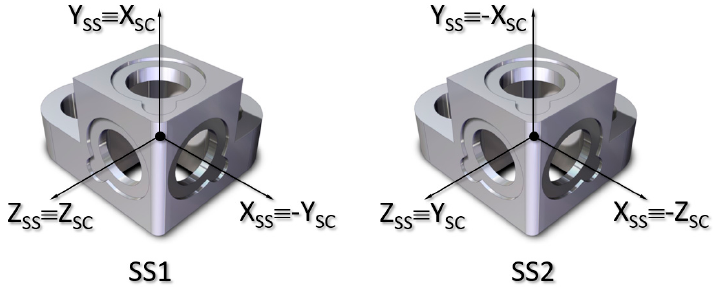
Figure 4. Solar sensor reference system (X SS , Y SS , and Z SS ) and its correspondence with the satellite reference system (X SC , Y SC , and Z SC ) for the SS1 sensor and the SS2 sensor, respectively.